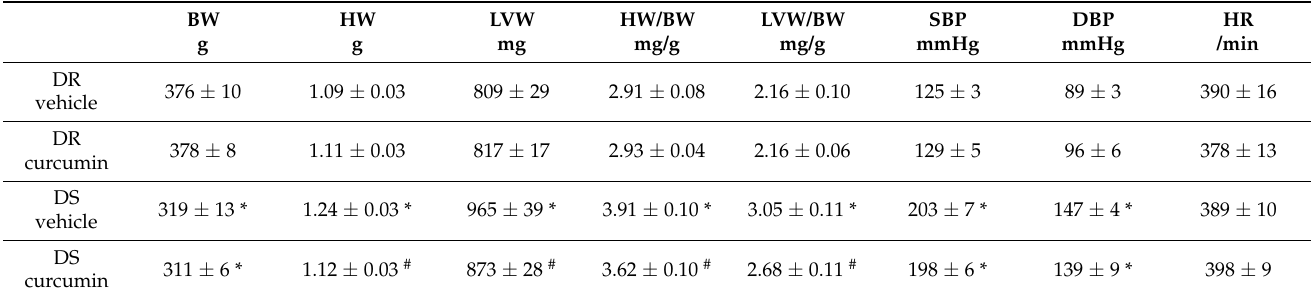
Table 2. BW, HW, LVW, and blood pressure parameters in Dahl rats at 12-weeks-old.